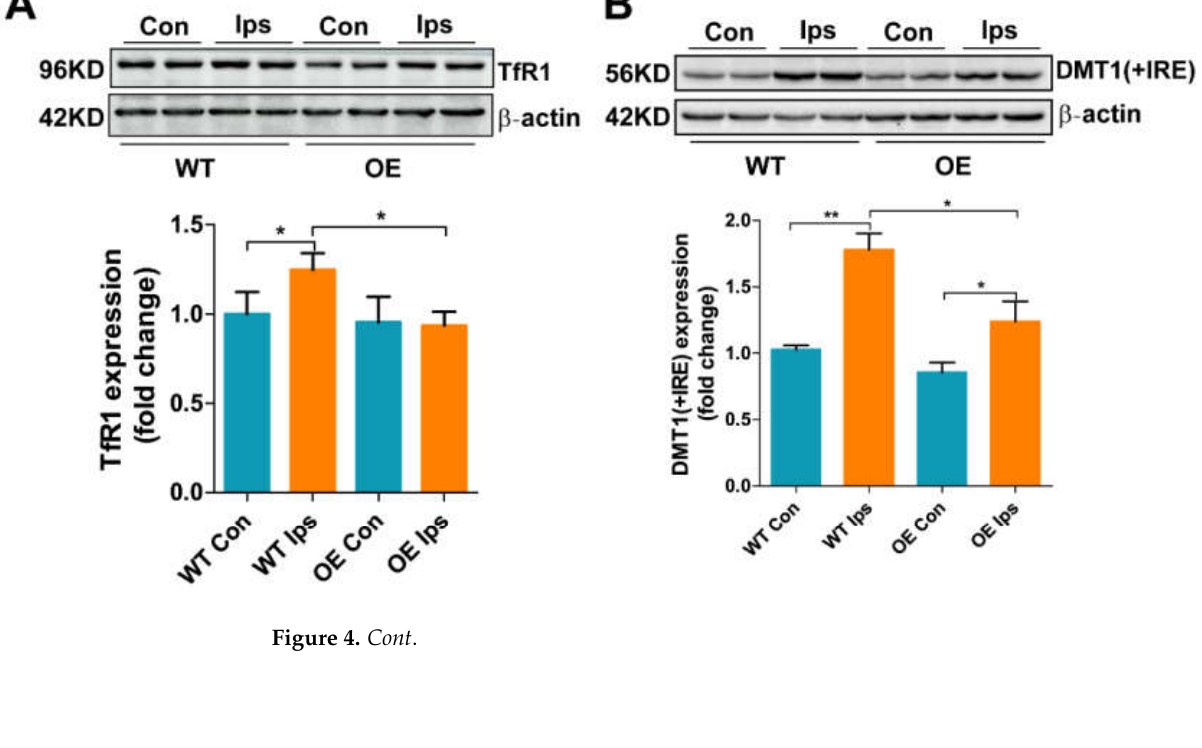
Figure 4. Overexpression of FtMt rescues I/R-induced iron dysregulation and oxidative stress in BMVECs. Western blot and densitometric analyses of ( A ) TfR1, ( B ) DMT1(+IRE), ( C ) FPN1, ( D ) FtL and ( E , F ) 4-HNE. The results are normalized to the  -actin levels and the data are expressed relative to the mean value in the WT Con group ( n = 4). The results are presented as the mean  SEM. * p < 0.05, ** p < 0.01.